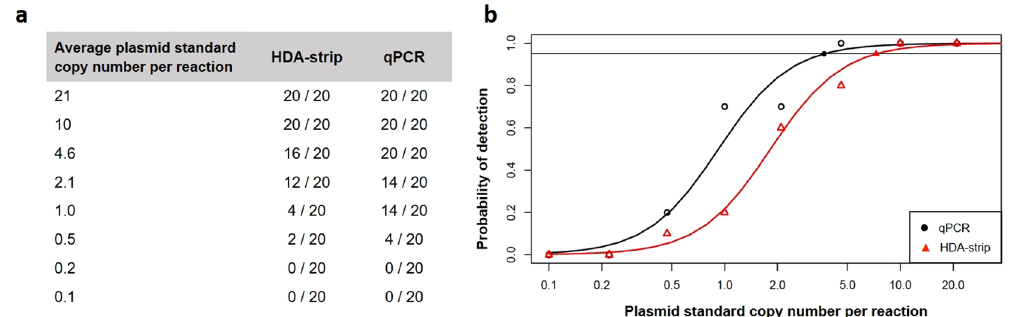
all ruminant from non-ruminant faecal samples (only one false-positive result was produced in a single replicate analysis of the wild boar sample). Exemplary results of the HDA-strip assay are shown in Supplementary Fig. S3. This performance suggests that the adaptation of the qPCR primers and probe to the HDA-strip test platform had no adverse effects on the diagnostic utility of the assay. Analytical limit of detection (LOD ). We used a defined plasmid standard carrying a single copy of the 95% BacR marker to determine the analytical limit of detection (LOD 95% ). To this end, we serially diluted the plas- mid standard to concentrations ranging from 21 to 0.1 copies per reaction and analysed the dilution series with both the HDA-strip assay and the qPCR assay in 20 replicates each. The results were statistically analysed with R software using the logistic regression model (Fig. 2). We determined an LOD 95% of 7.3 copies per reaction for the HDA-strip assay (95% confidence range: 5.2–10.3 copies) and 3.7 copies per reaction for the qPCR assay (95%